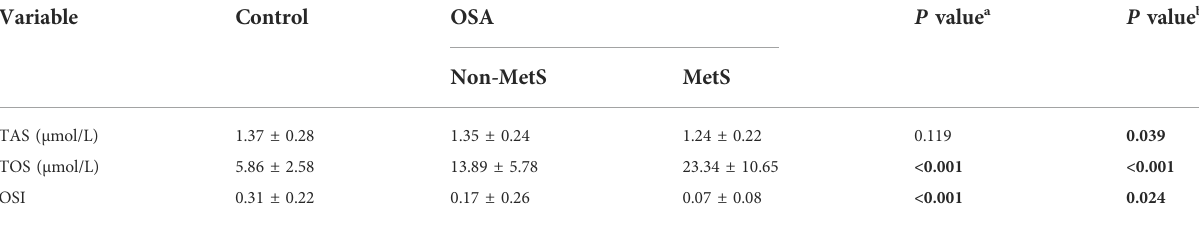
TABLE 3 Correlations of oxidative indicators with the presence of MetS in OSA patients.